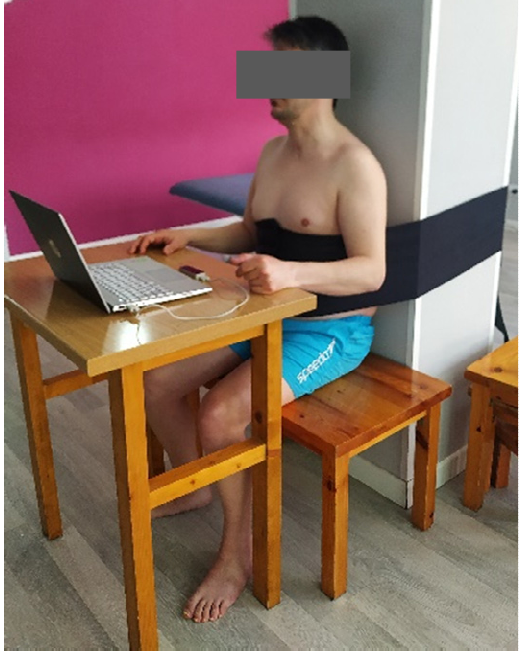
Figure 3. Position of the